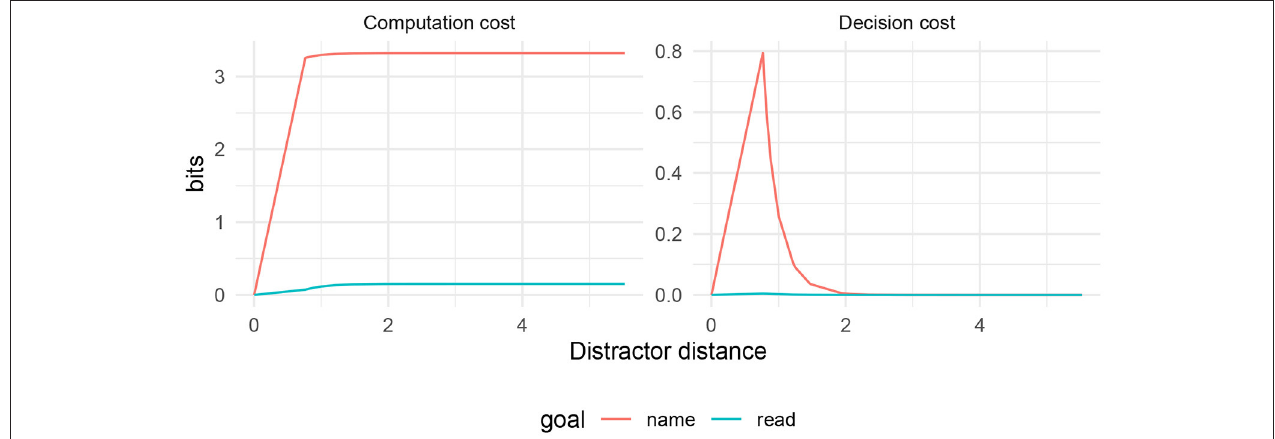
FIGURE 5 | Simulated costs in Picture–Word Interference task, as a function of semantic distance between target and